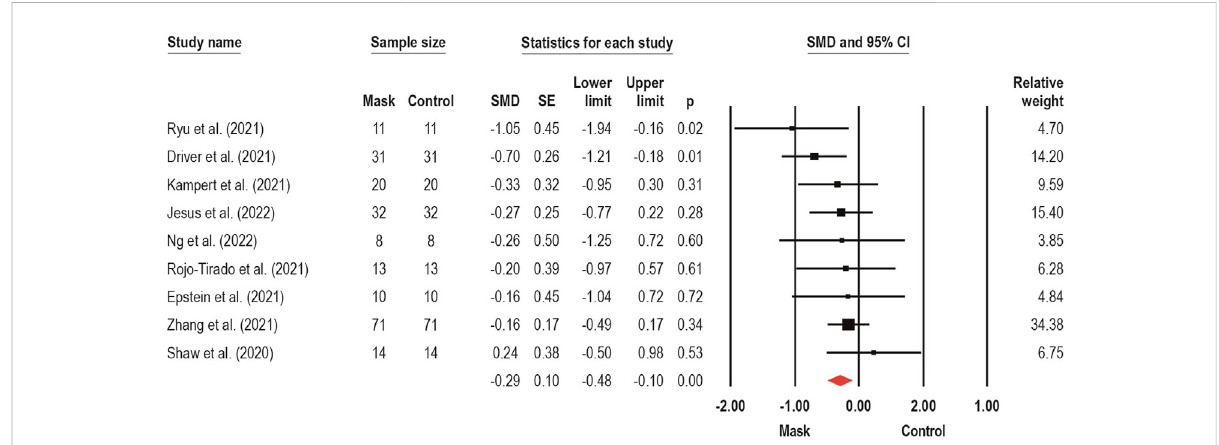
FIGURE 5 Acute effects of face mask vs. control (unmasked condition) on time-to-exhaustion performance. Forest plots with pooled standardized mean difference (SMD), standard errors (SE), and 95% con fi dence intervals (CI) are displayed: (SMD: − 0.29; 95% CI − 0.10 to − 0.48; p < 0.001; I 2 = 0%).